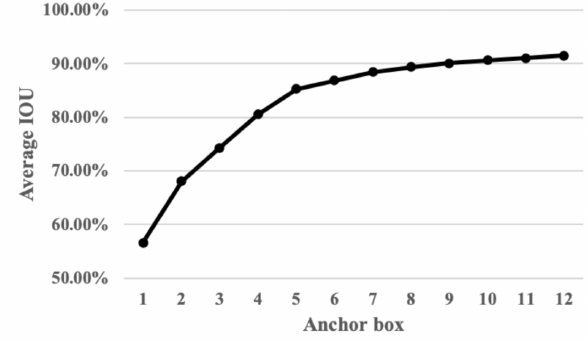
Figure 14. The relationship between the number of anchor boxes and average